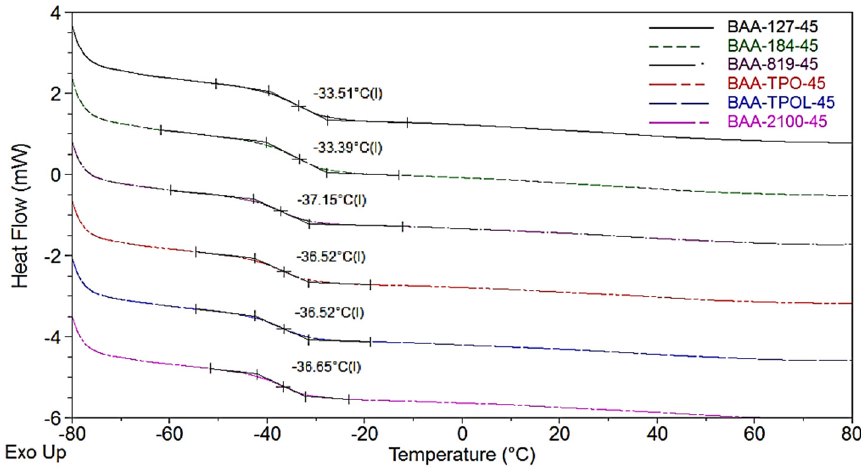
Figure 8. T g values of PSAs based on BAA cotelomer.